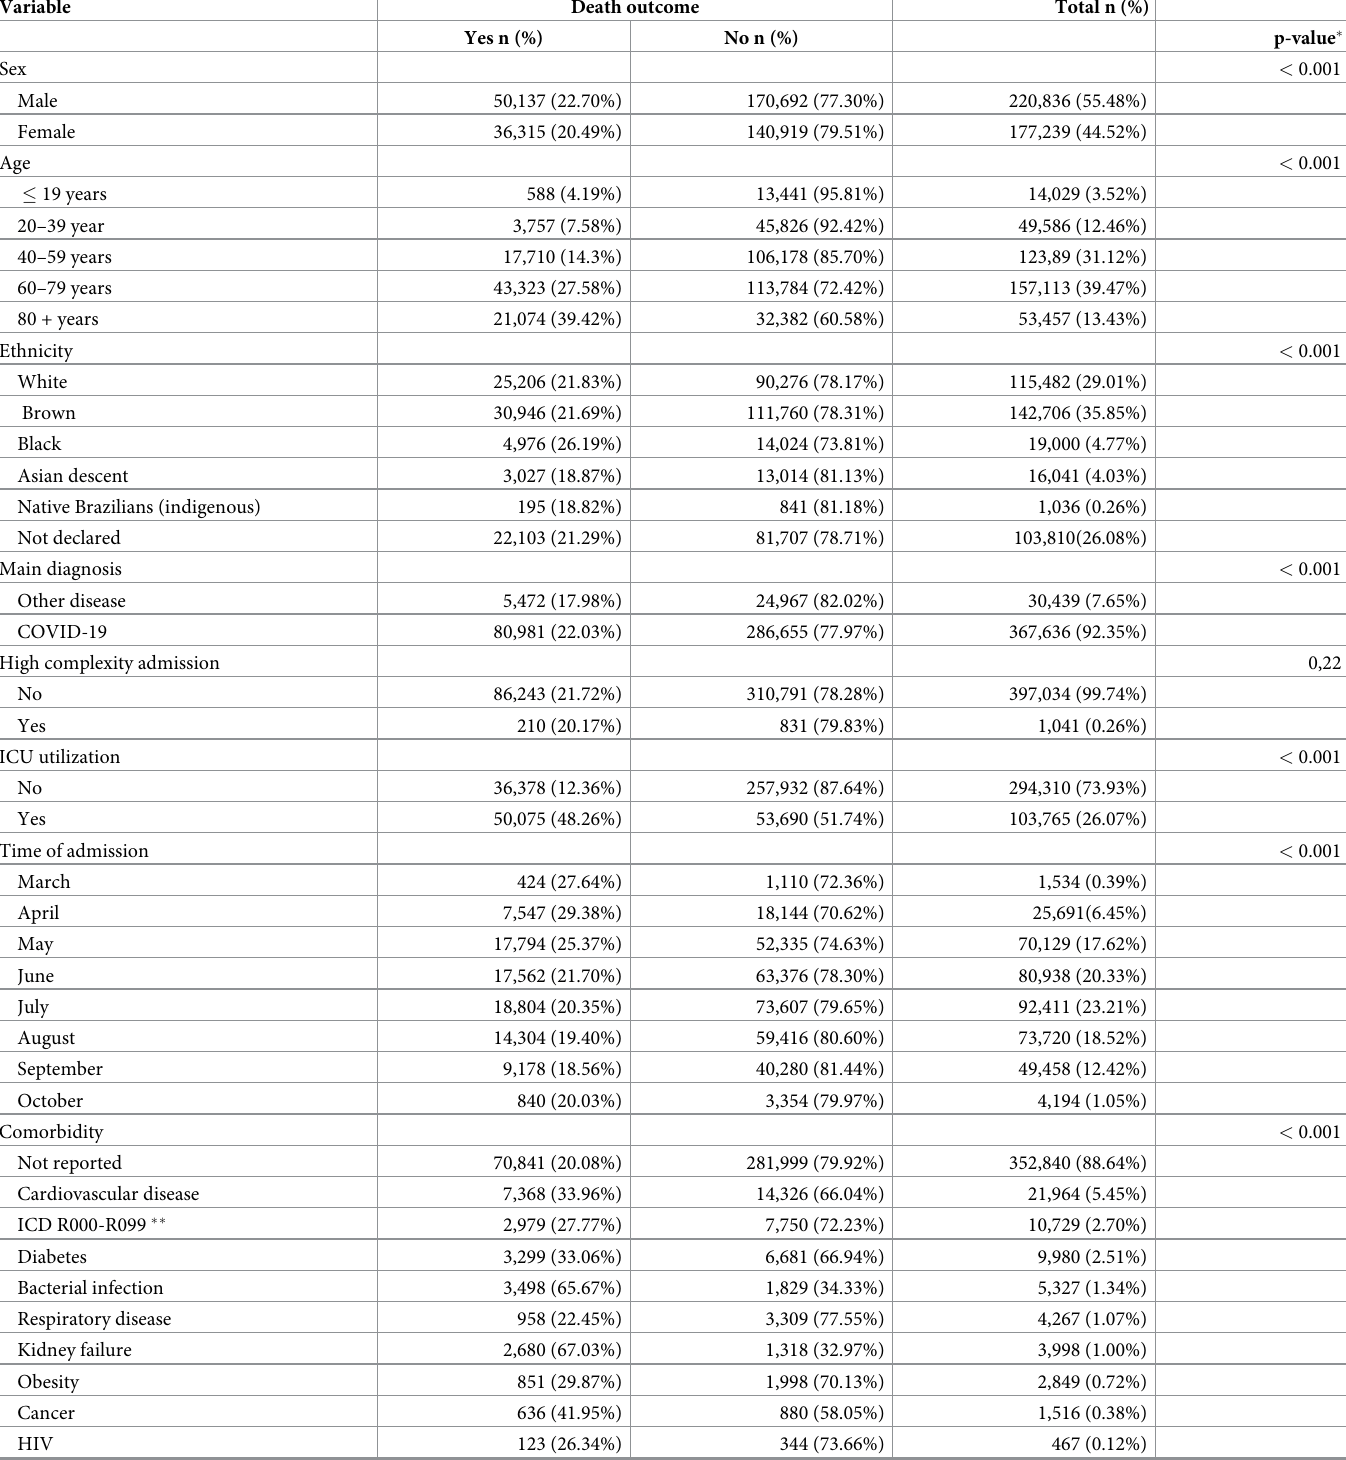
Table 1. Characterization of 398,063 COVID-19-related hospital admissions, Brazil, 1 st March to 3 rd October